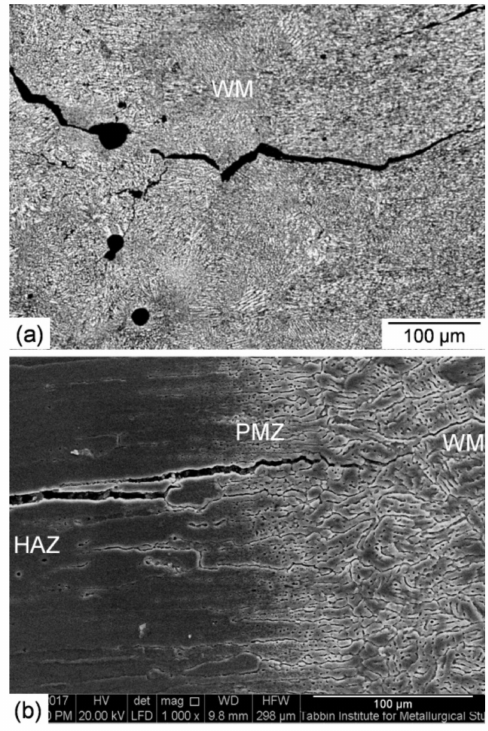
Figure 7. Optical ( a ) and low-magnification SEM ( b ) photographs of a cross-section of the high heat input laser-welded